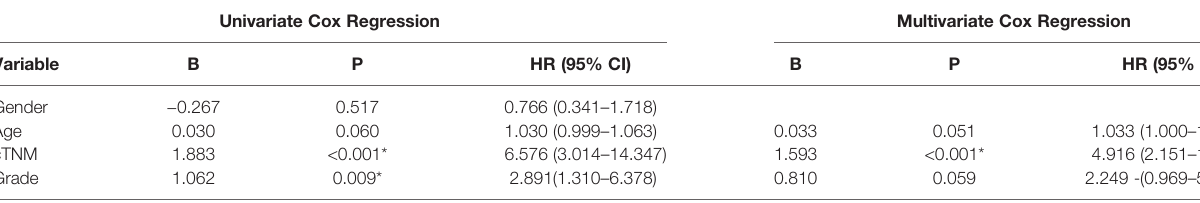
TABLE 2 | Univariate and multivariate Cox regression analyses of clinicopathological parameters.